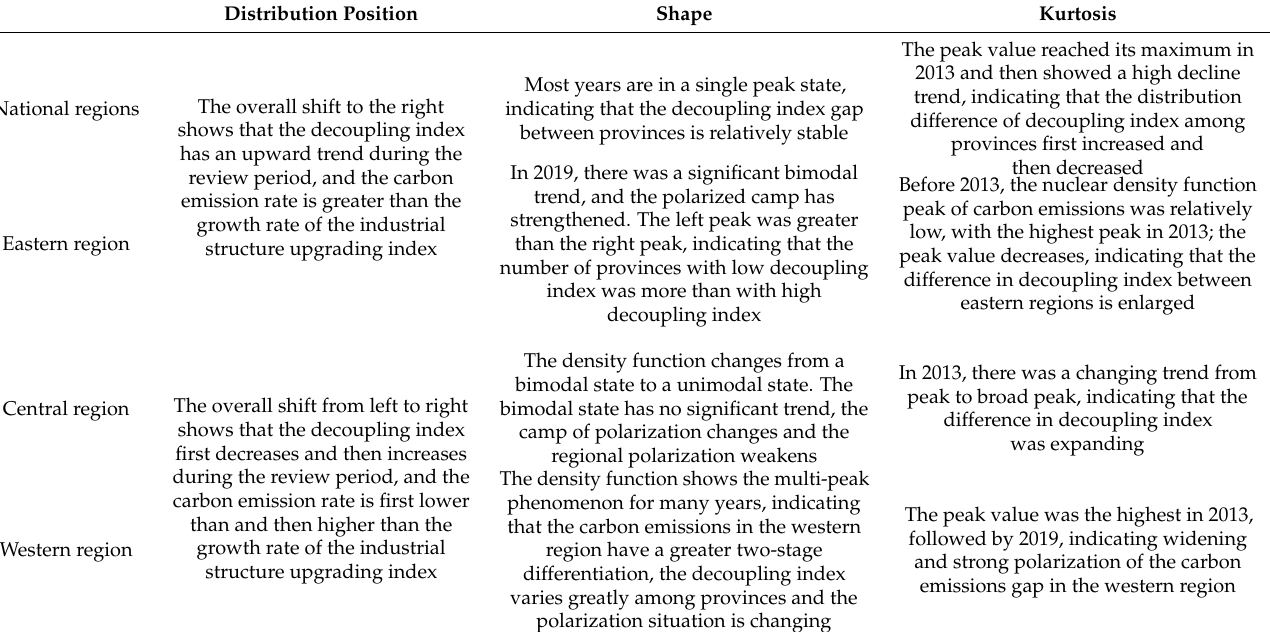
Table 4. Nuclear density estimation results of China and the east, middle and west regions.